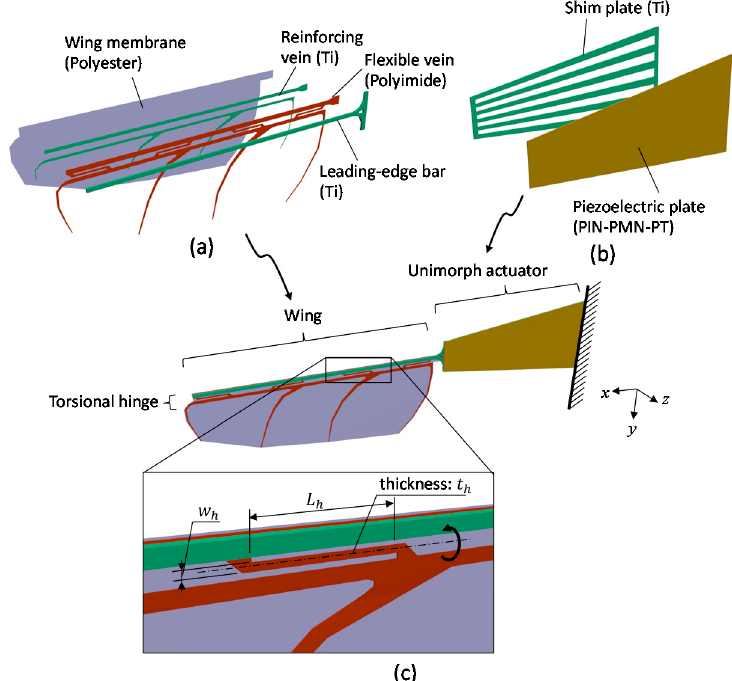
Figure 4. Structure of prototype actuation system: components of ( a ) wing and ( b ) unimorph actuator; and ( c ) assembled system and a close-up image of hinge.